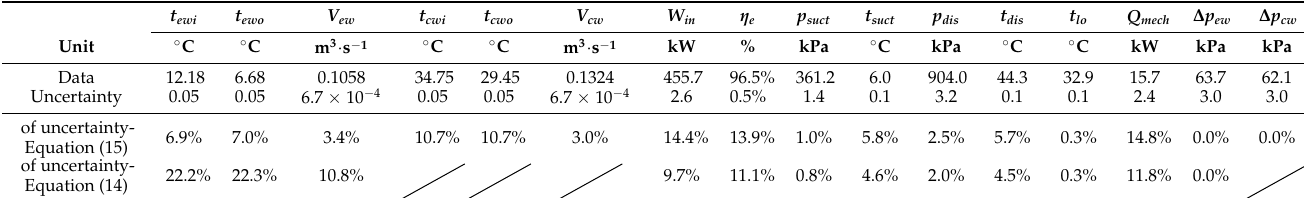
Table 3. Uncertainty of input parameters and their contributions to E fg